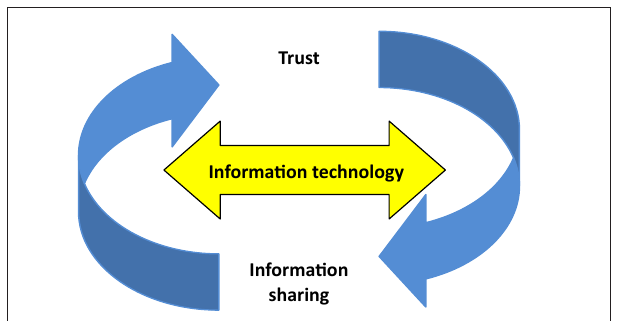
FIGURE 1: The trust-information sharing